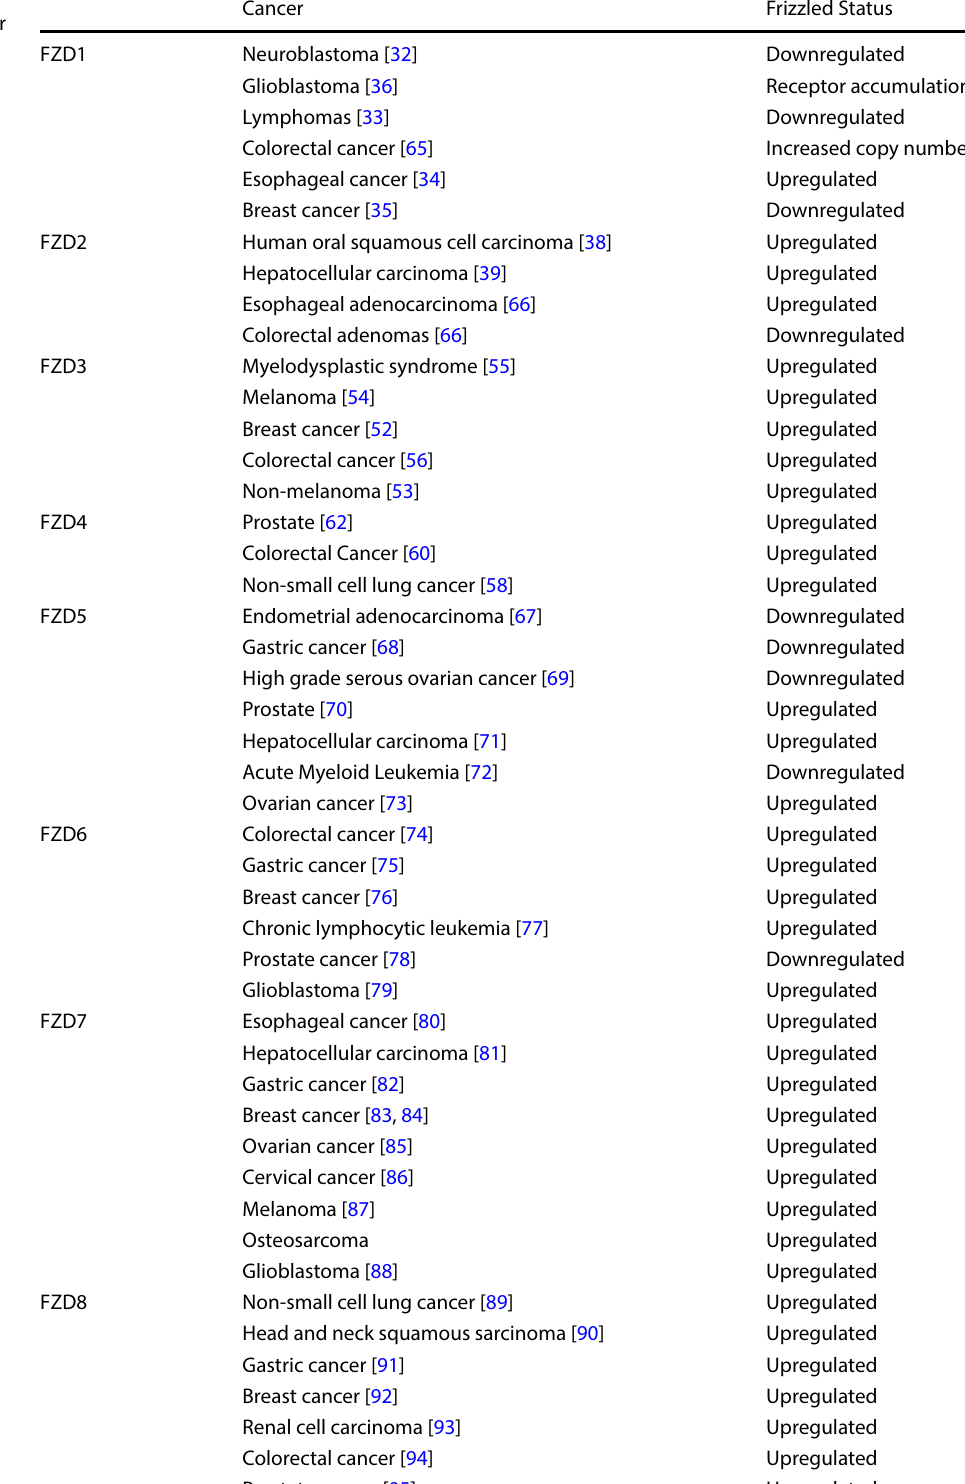
Table 1 Status of FZDs associated with EMT in